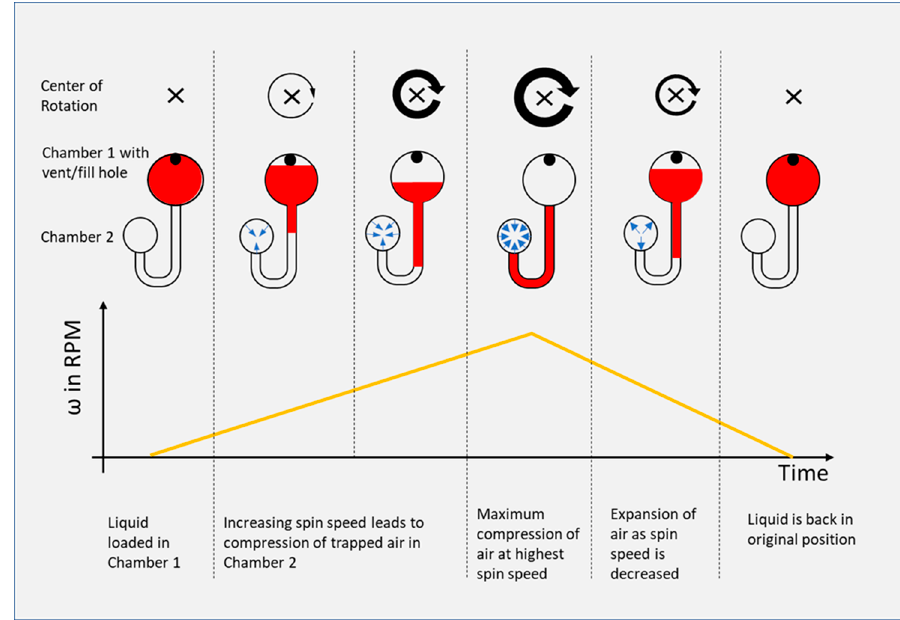
Figure 1. Basic principle of an air compression chamber for (ideal) reciprocation of fluid on a microfluidic disc.